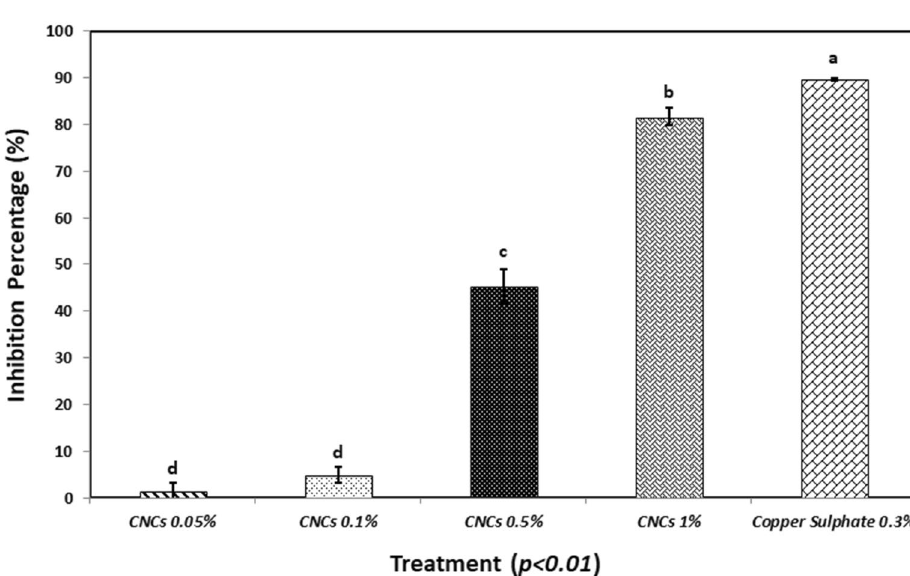
Figure 2. In vitro inhibition of Pseudomonas savastanoi pv. savastanoi by different cellulose nanocrystals concentrations (0.05, 0.1, 0.5, 1% w/v) at 48 h. Copper sulphate pentahydrate at 0.3% w/v was used as control. Statistical significance was based on a p -value < 0.01. Error bars represent the standard deviation between eight replicates. In vitro experiments were conducted thrice, and the effect of the experiment was not